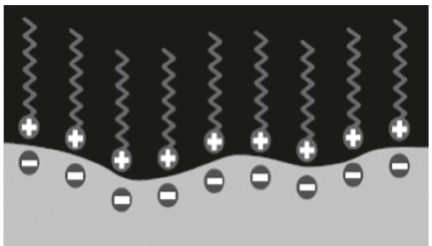
Figure 1: Cationic surfactants as a bridge between the bitumen and aggregates.